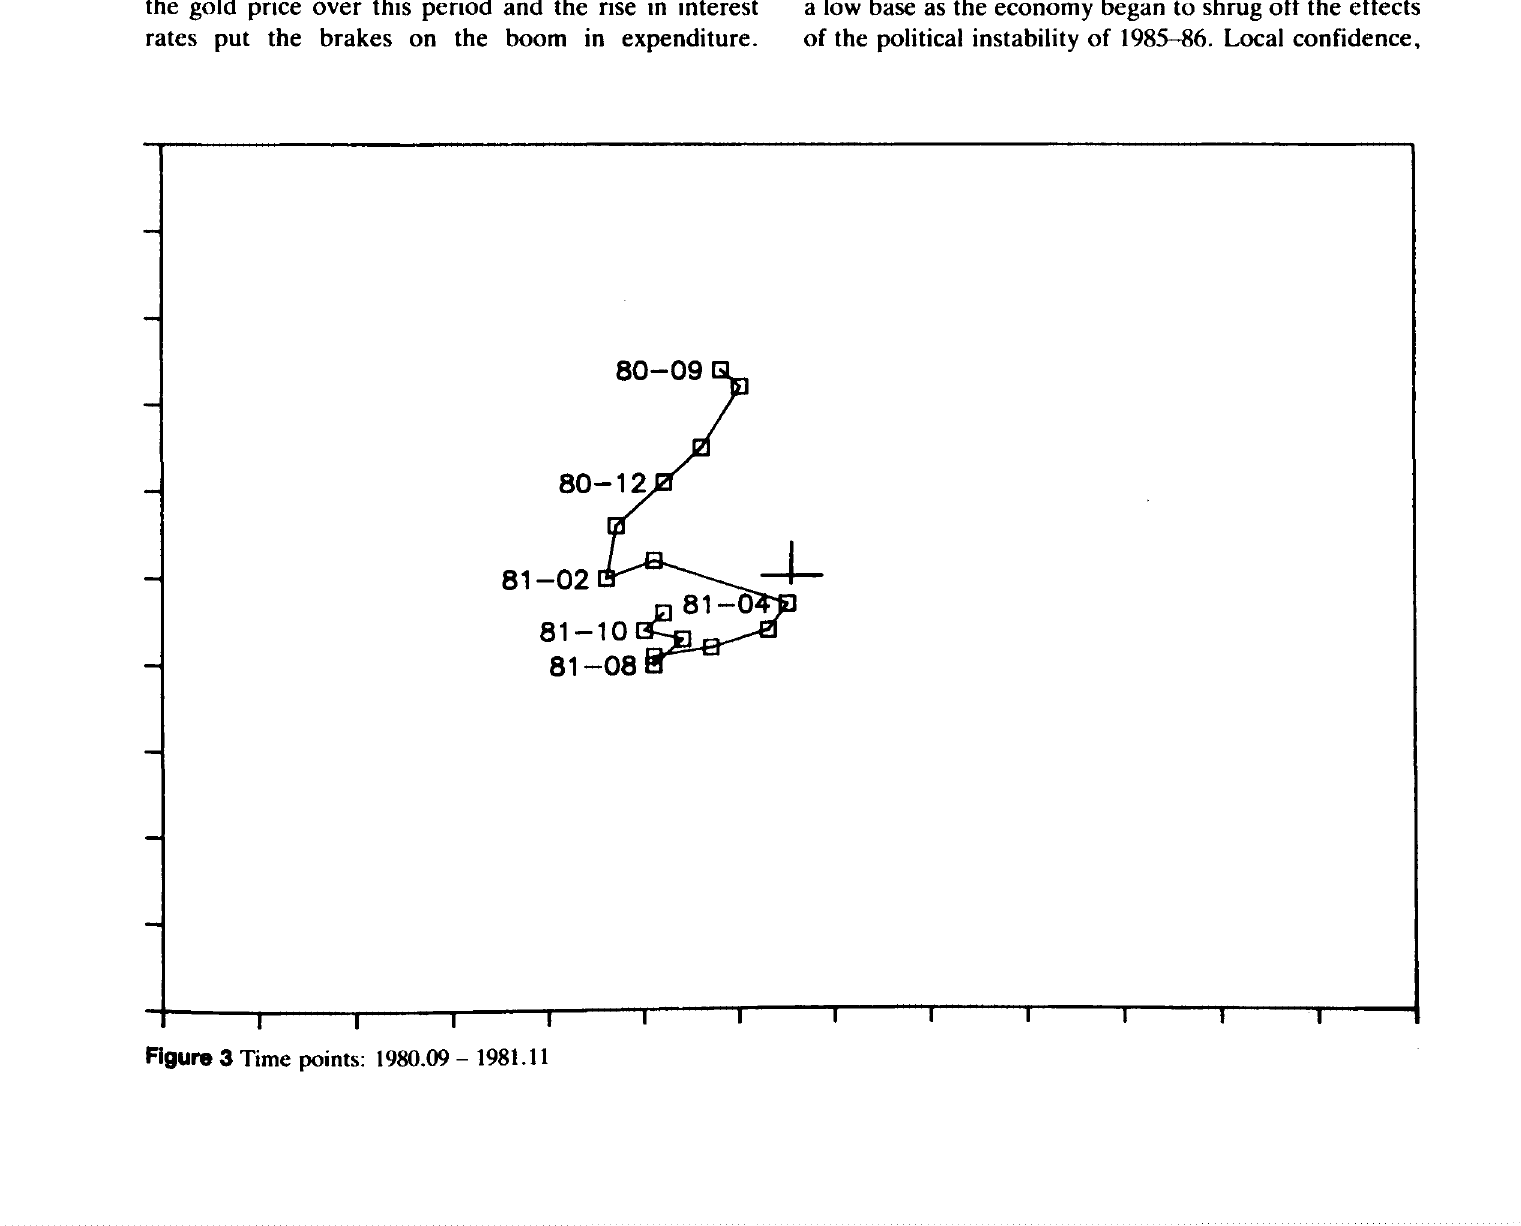
Figure 3 Time points: 1980.()9 -